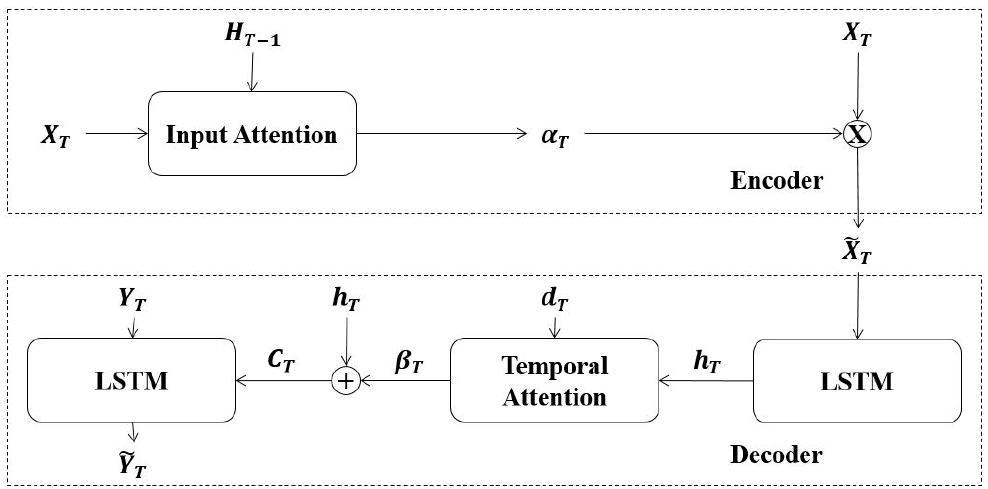
Figure 3. Proposed dual-stage attention